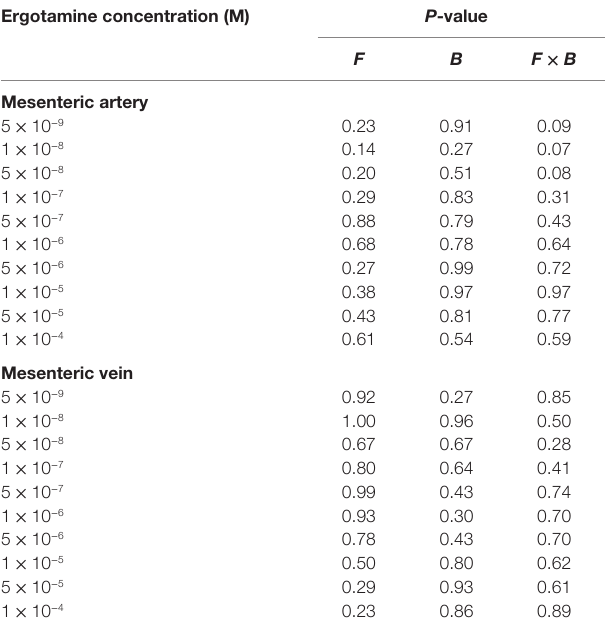
FigUre 2 | Mean contractile response, as % Kcl maximum of mesenteric artery to increasing concentrations of ergotamine for pretreatments without tall fescue seed extract: only Krebs–henseleit buffer (control); 1 × 10 − 6 M formononetin ( F ); or 1 × 10 − 6 M biochanin a ( B ); and combination of 1 × 10 − 6 M F and 1 × 10 − 6 M B ( F + B ) . The regression lines were plotted for each treatment using a non-linear regression where top and bottom are the plateaus of contractile response as percentage of 120 mM KCl maximum response. EC 50 is the molar concentration of ergotamine inducing 50% of the KCl maximum response. TaBle 3 | The analysis of variance and P -values of main effect of formononetin ( F ), biochanin a ( B ), and the interaction of formononetin and biochanin a ( F × B ) for pretreatments without tall fescue extract: only Krebs–henseleit buffer; 1 × 10 − 6 M F , B , and combination of F and B on every ergotamine concentration.